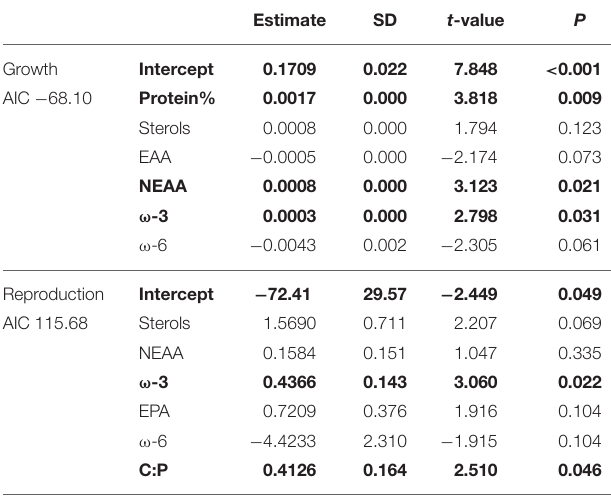
TABLE 3 | GLM results for growth and reproduction of Daphnia fed with medium, high and superior quality phytoplankton, i.e., excluding cyanobacteria, dinoflagellates, and